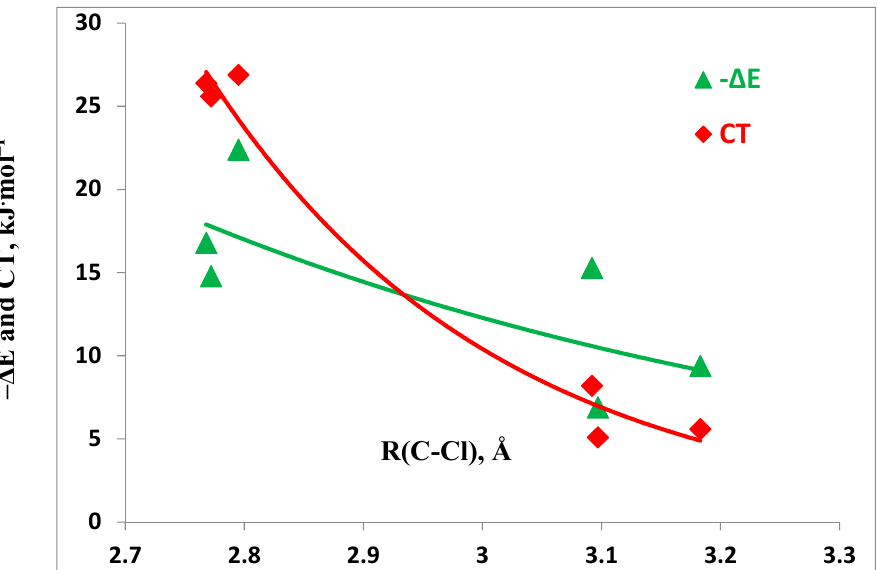
Figure 5. Binding energies and charge-transfer energies versus the C-Cl distance for Complexes SC:ClY.